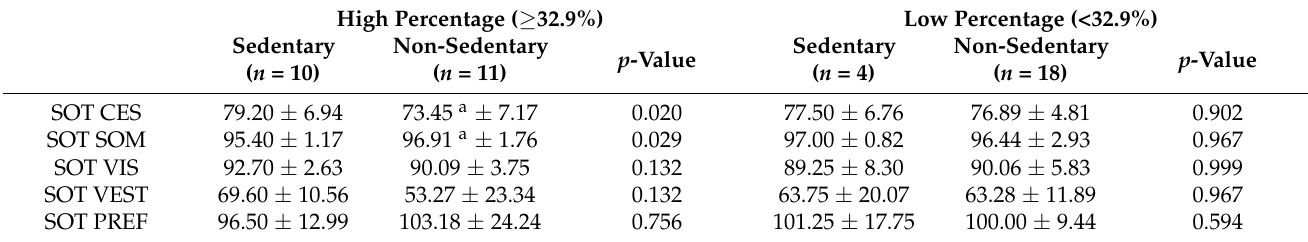
Table 2. Comparison of the postural control tests in individuals with a low or high total fat mass percentage. High Percentage ( ≥ 32.9%) Low Percentage (<32.9%)